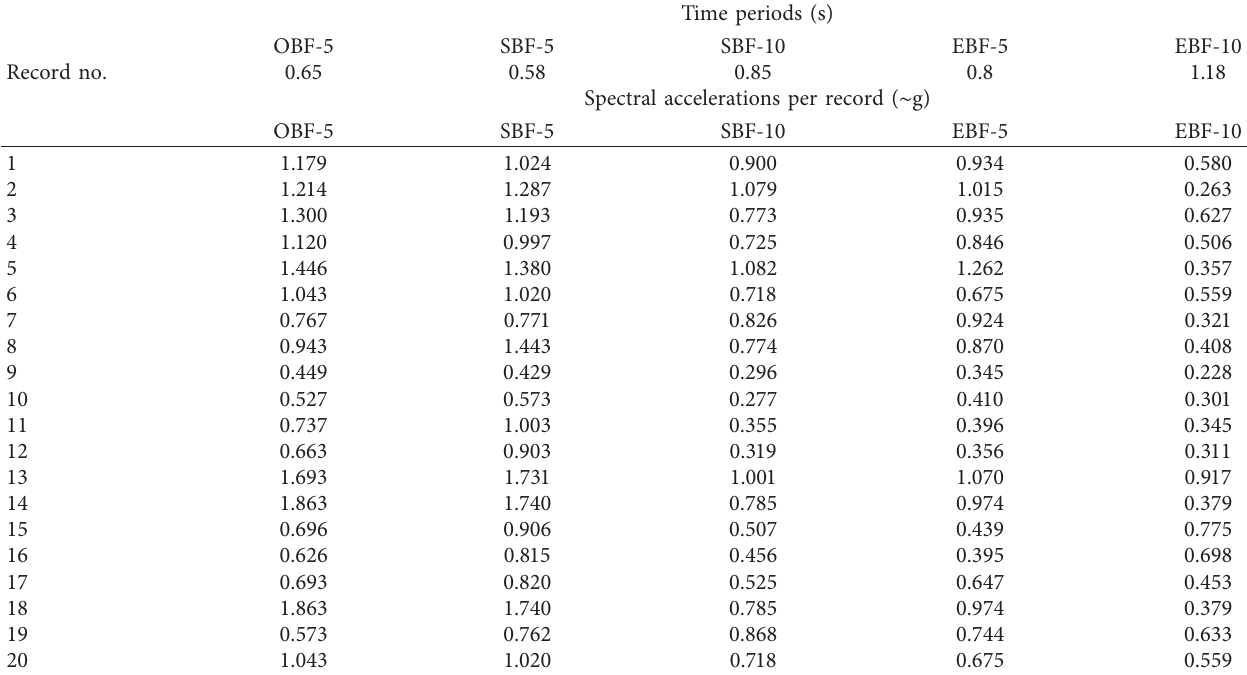
Table 3: Spectral acceleration per response spectrum equivalent to each seismic